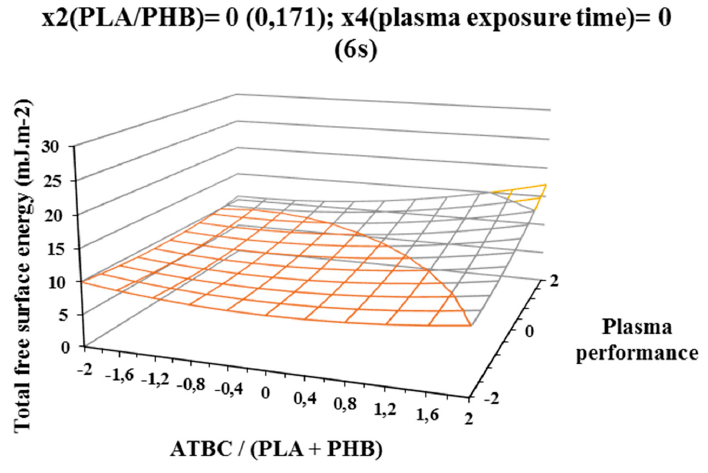
Figure 6. Response surface of difference of the polar component of free surface energy measured immediately after plasma surface treatment in dependence of factors x1 (ATBC/(PLA + PHB)) and x3 (plasma power) at constant factor x2 (PHB/PLA) = 0 and x4 (plasma exposure time)) = 0 .